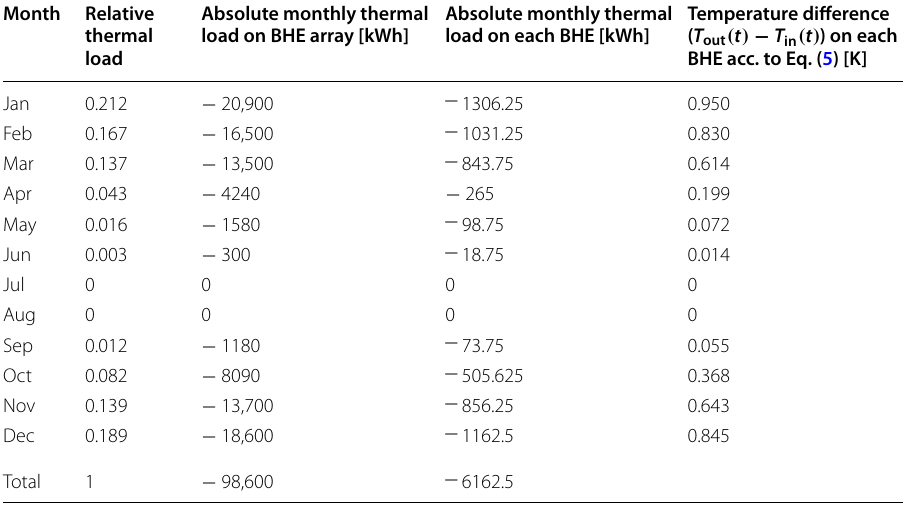
Table 1 Distribution of monthly thermal load over one year from the building, along with calculated values for the